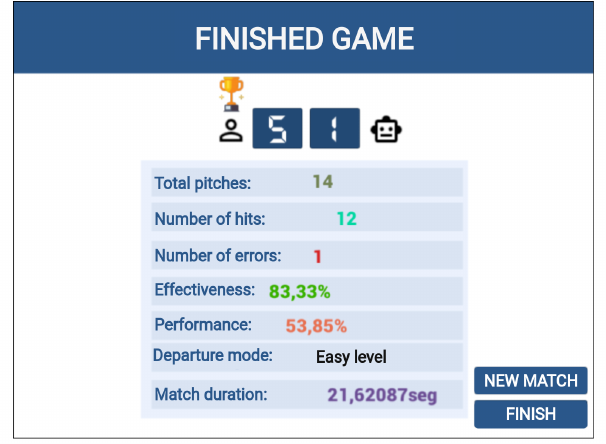
Figure 6. Feedback at the end of the game. Source: Author